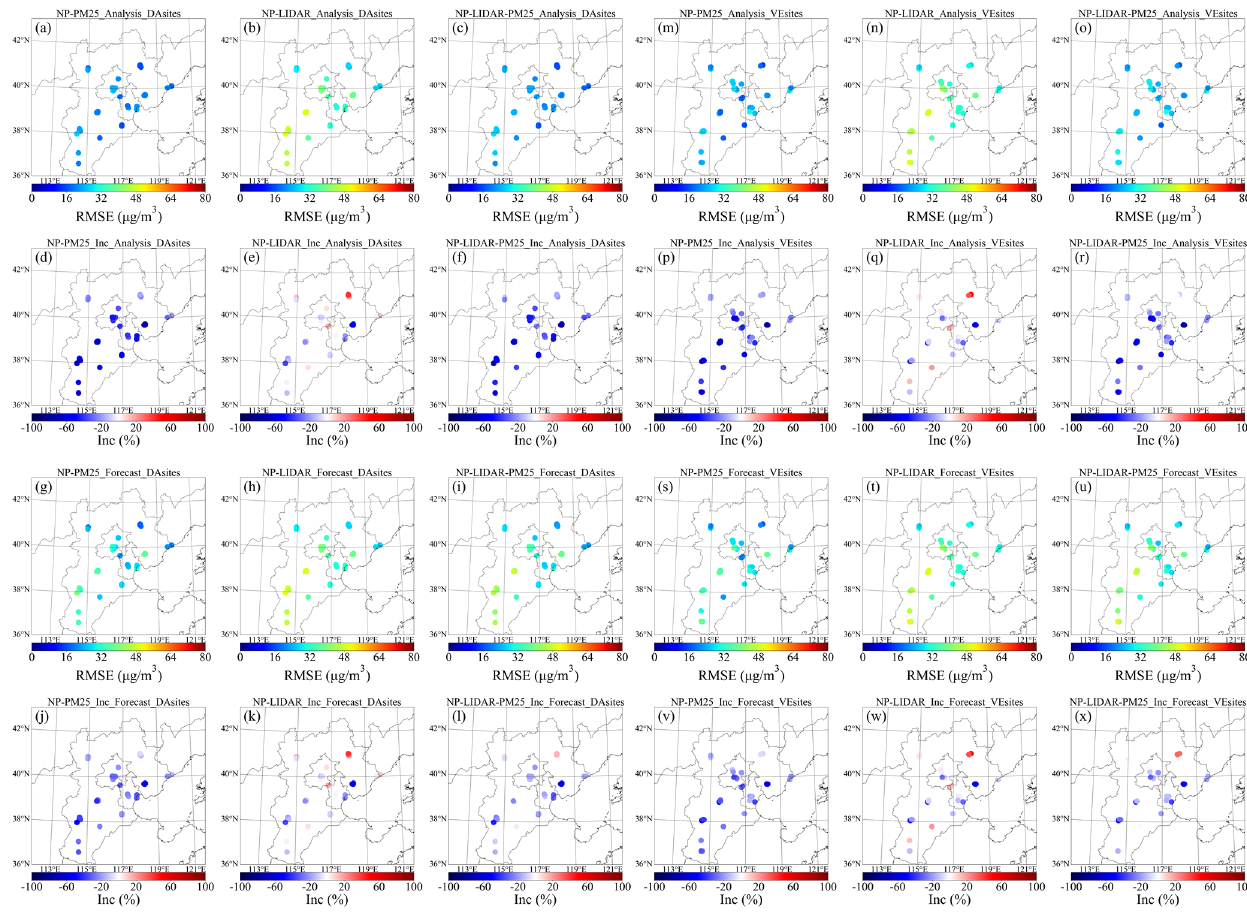
Figure 10. Spatial distributions of the RMSEs (km − 1 ) of the surface PM 2 . 5 analysis (a, b, c) , the increments in the RMSEs of the surface PM 2 . 5 analysis (d, e, f) , the RMSEs of the surface PM 2 . 5 forecast (g, h, i) , and the increments in the RMSEs of the surface PM 2 . 5 forecast (j, k, i) for the NP-PM25, NP-LIDAR, and NP-LIDAR-PM25 experiments among DA sites. Panels (m) – (x) are the same as panels (a) – (l) but for VE